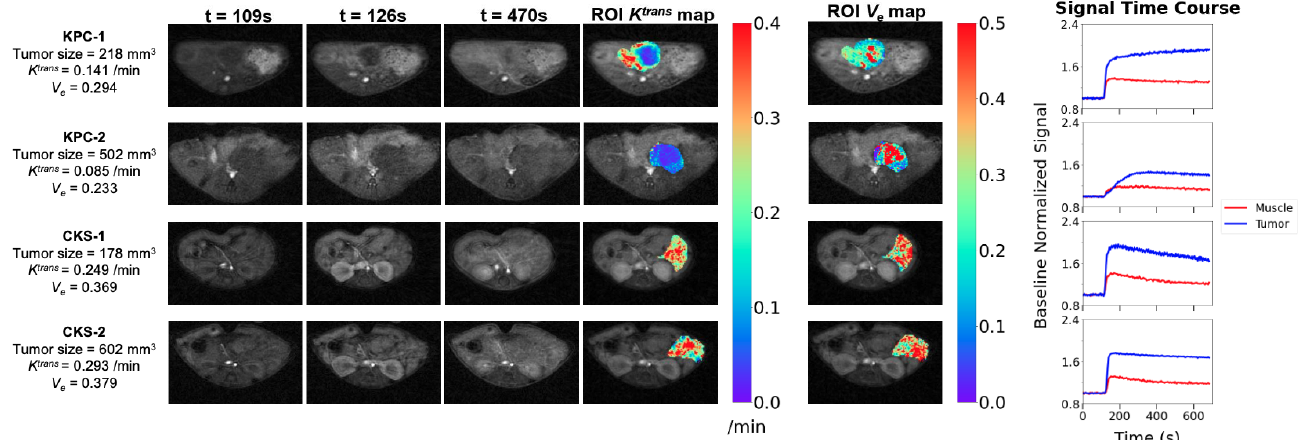
Figure 5. Comparison of quantitative DCE-MRI features and parametric maps between KPC and CKS tumors. For 2 KPC and 2 CKS mice, contrast enhanced images before, shortly after, and minutes after contrast agent bolus are shown, as well as resulting K trans and v e maps of the tumor ROI and the signal time-course for the full tumor and spinal muscle (reference region) ROIs. t marks the time after initiation of DCE acquisition. Contrast media is injected at 120 s. Images are cropped. Refer to Figure S1 for an example of ROI placed for spinal